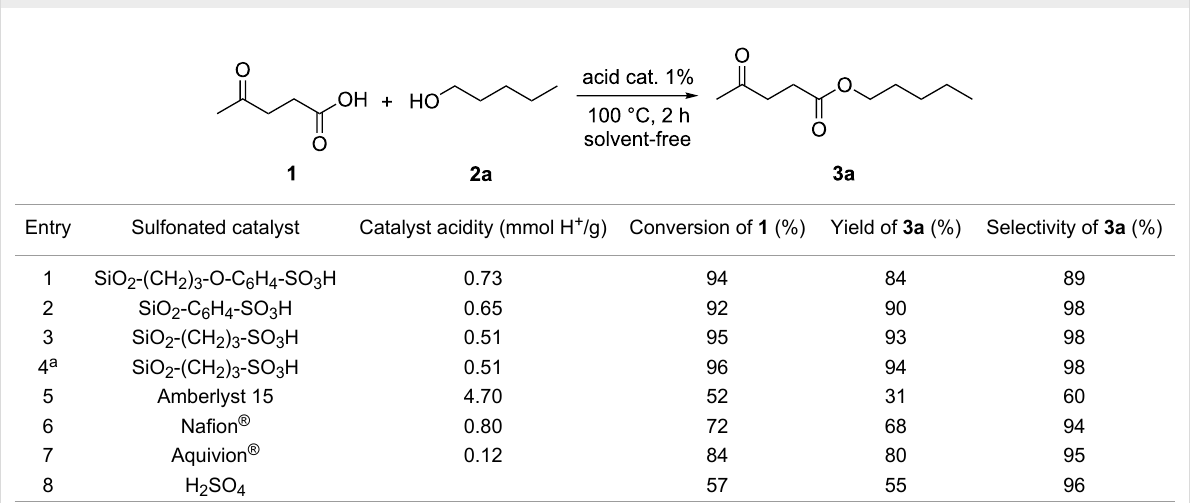
Table 1: Screening of different solid acids in the esterification reaction of levulinic acid with 1-pentanol.